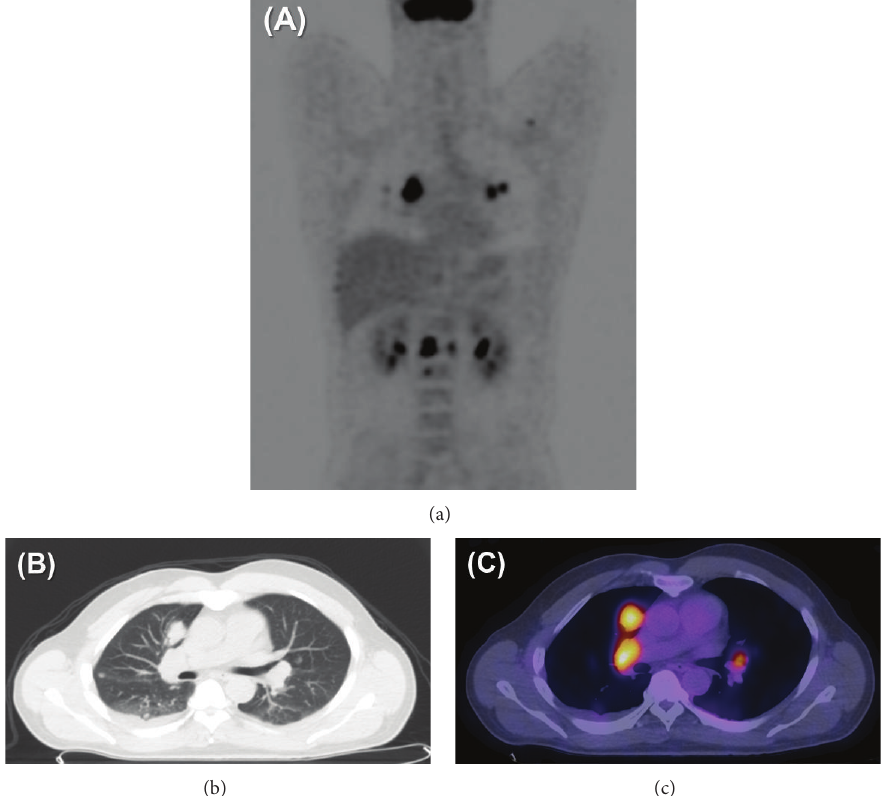
Figure 2: (a) Whole body FDG PET imaging demonstrating hypermetabolic osseous and visceral metastases including bilateral pulmonary nodules and hilar adenopathy. (b) CT imaging demonstrating mediastinal adenopathy, multiple pulmonary nodules, and right pleural effusion. (c) Coregistered PET/CT imaging demonstrating intense FDG uptake within GBM lung